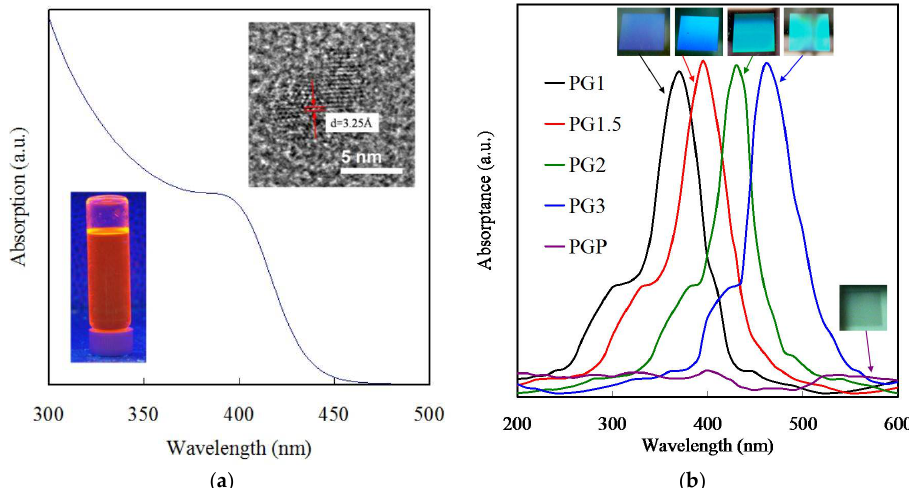
Figure 4. UV–vis reflectance absorptance spectra of ( a ) CQDs, inserts represent the TEM images and photography of CQDs, and ( b ) PG1, PG1.5, PG2, PG3, and planer sample.